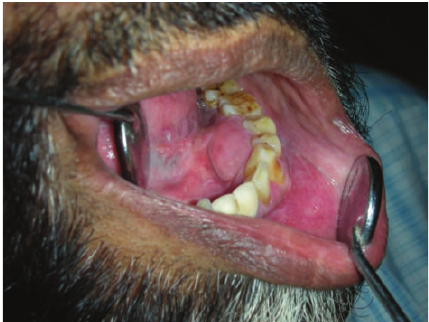
Figure 2: OPG of the patient reveals a large multilocular radiolu- cency.